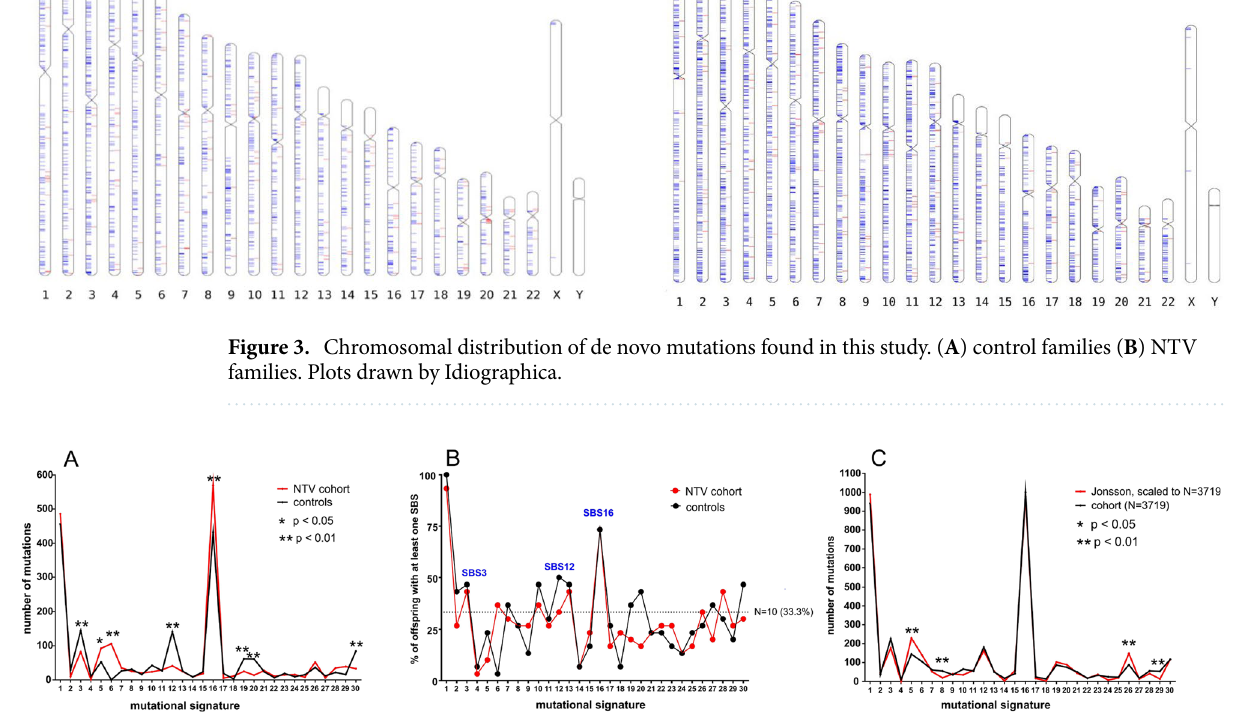
Figure 4. The spectra of mutation signatures in controls and NTV families. ( A ) Frequency of SBS mutations per signature. Data were fitted to the COSMIC v3.2 database with signature fitting distributing each mutation to one (and only one) signature. ( B ). Families (offspring) with at least one mutation per signature. ( C ) SBS signature profiles for the Icelandic cohort and the combined control plus NTV cohorts 11 . Data were fitted to the COSMIC v3.2 database in the same way as the NT and control cohorts, downscaled to the sample size of SNVs identified in our cohorts i.e. N = 3719 in 60 probands. Statistical difference judged on a signature-to-signature basis (Chi square test, multiple p value adjustment by the Holm